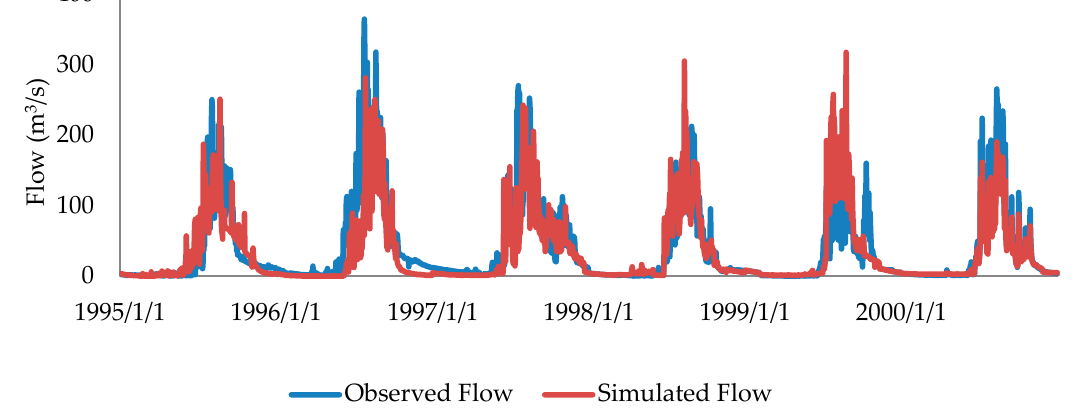
Figure 6. Comparison of simulated flow and observed flow for the validation period